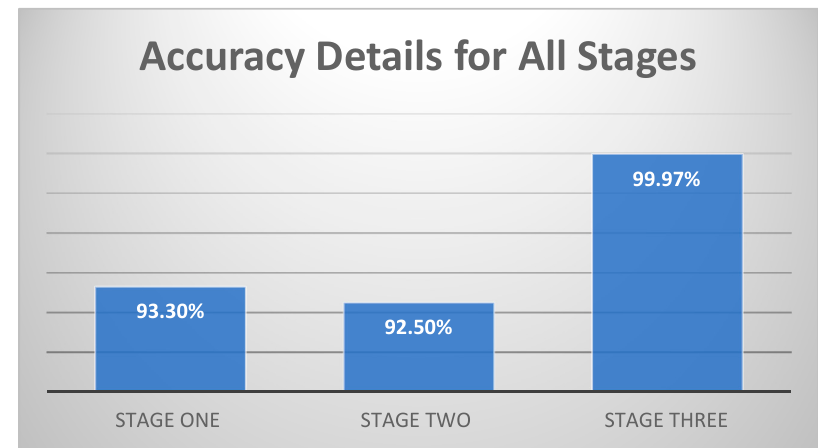
Figure 5. Accuracy details for all stages.